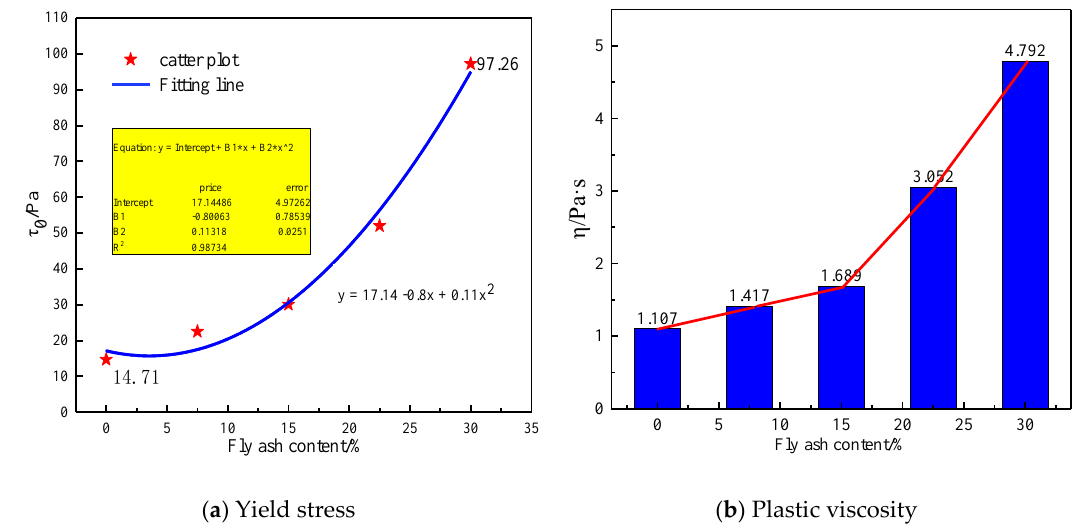
Figure 6. Effect of fly ash content on shear yield stress and plastic viscosity of slurry. Figure 6. E ff ect of fly ash content on shear yield stress and plastic viscosity of